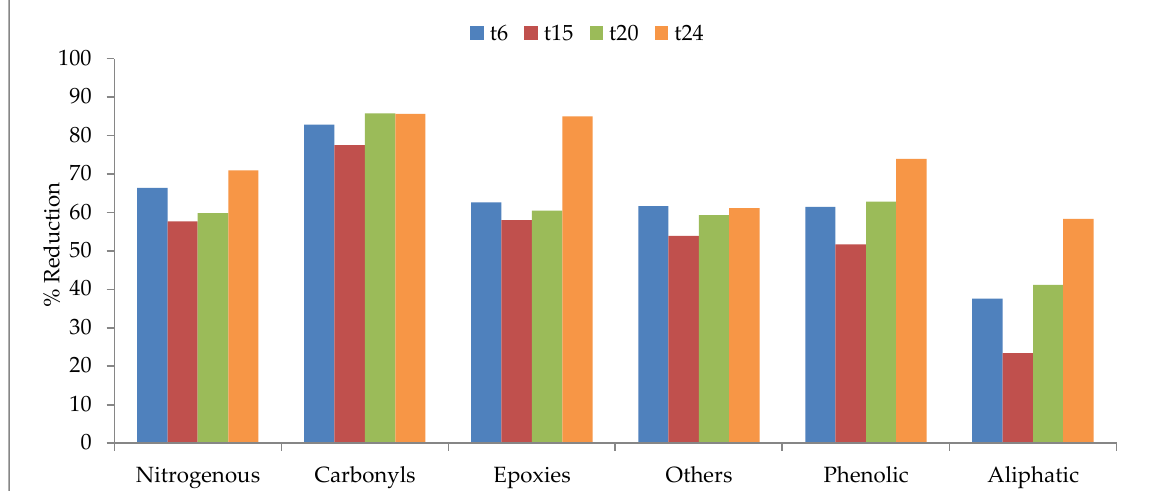
Figure 8. Reduction obtained for the different families of compounds in the total particular matter collected in the study of the time (h) at the first step of the synthesis with fixed conditions of temperature, 40 °C, and stirring rate, 700 rpm.